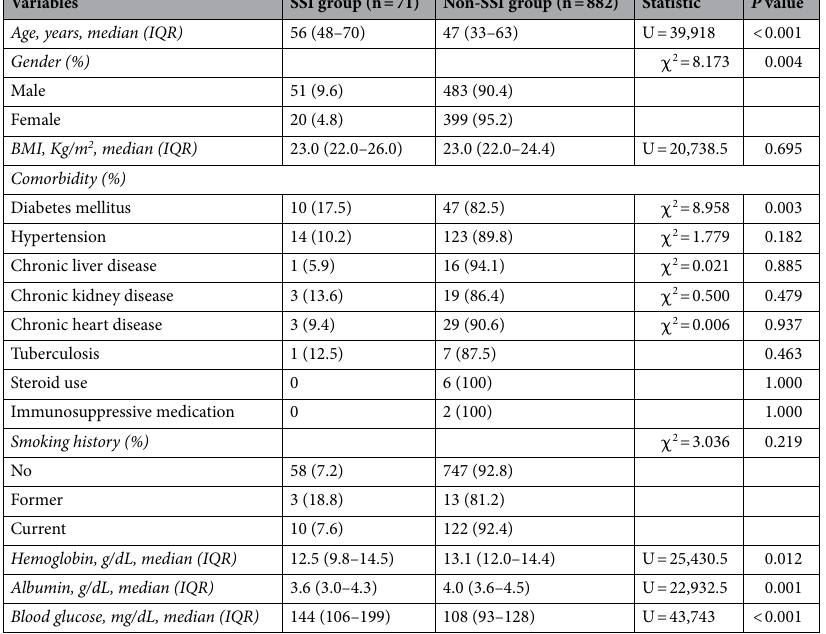
Table 1. Demographics of included